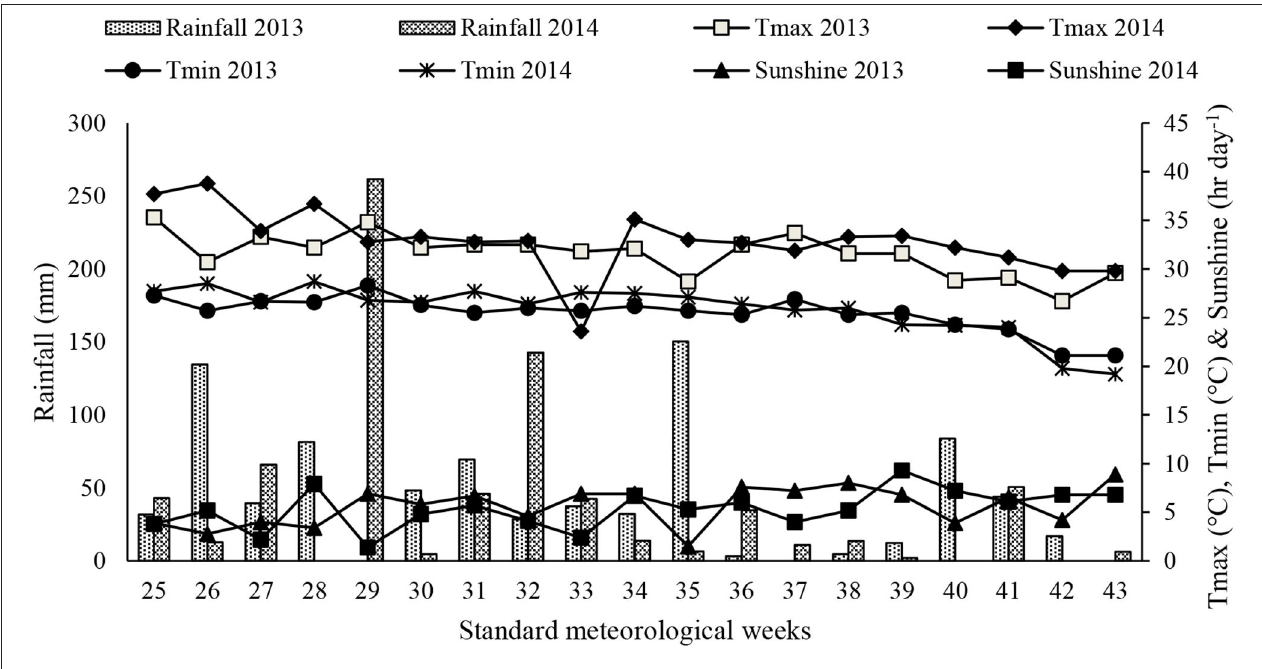
FIGURE 1 | Meteorological observations of rice season.